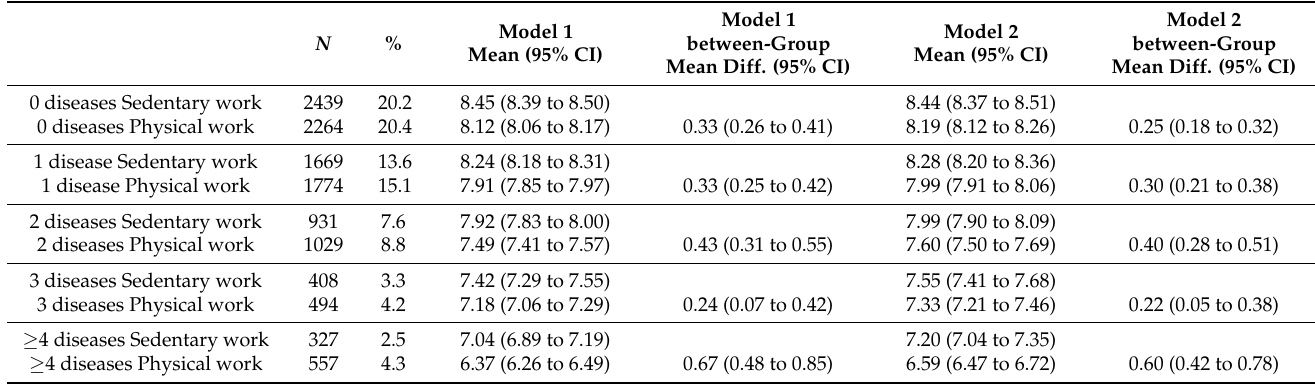
Table 3. The least square means and 95% confidence intervals (95% CI), as well as differences of the least square means, for work ability and the number of chronic diseases (multi-morbidity) stratified by job